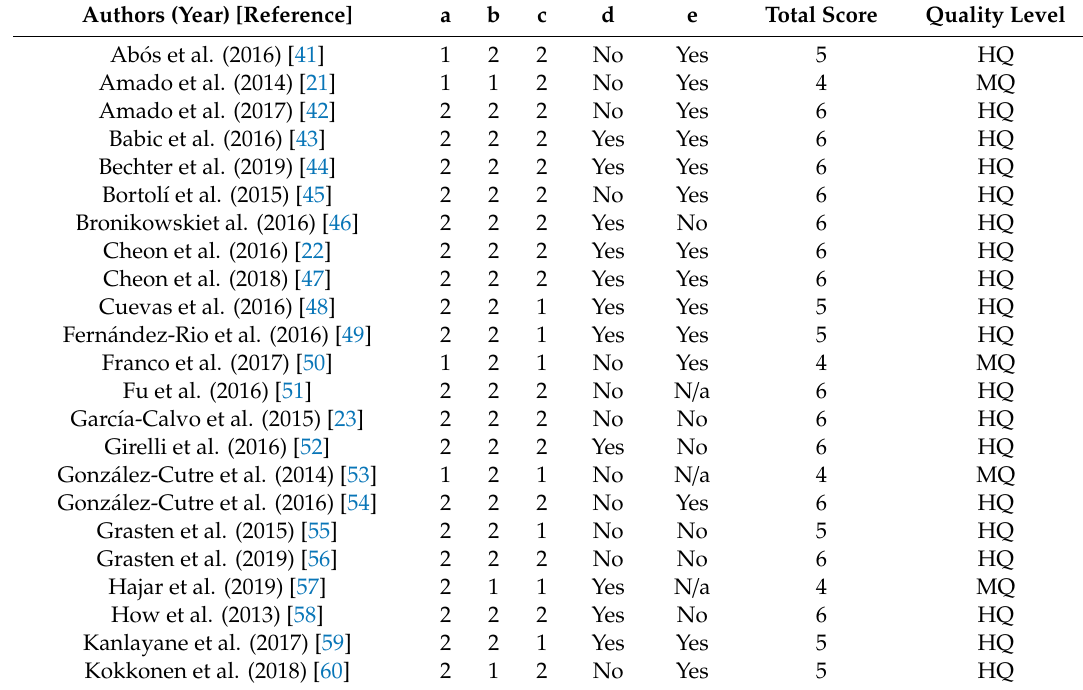
Table 2. Quality of